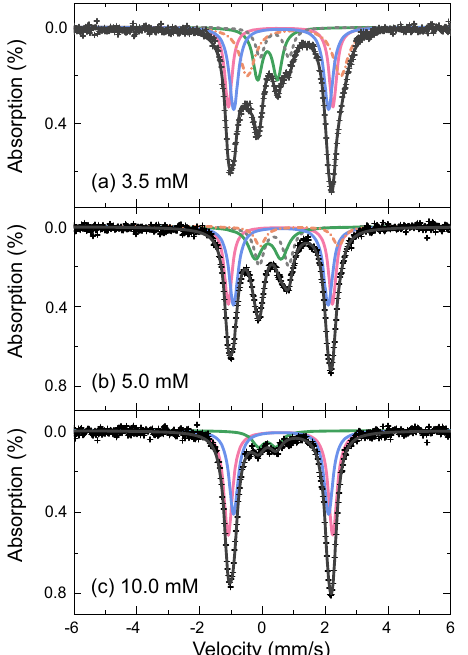
Fig. 5 Mössbauer spectroscopy reveals a variety of FeS cluster species. Room temperature 57 Fe Mössbauer spectra of FeS clusters coordinated with a 3.5 mM, b 5.0 mM and c 10 mM cysteine ligand at pH 9 (FeCl 3 and Na 2 S kept constant at 1 mM). All spectra were folded relative to α Fe, with best fi tting obtained using a least-squares fi tting method, by adding a number of Lorentzian shaped doublets. Crosses represent observed data points with the black line showing best fi t to the collected data. Each FeS cluster species is represented by a coloured line: mononuclear (pink line); [2Fe-2S] 0 (blue line); [2Fe-2S] 2 + (green line); [4Fe-4S] 2 + (grey dashed line); Fe 2 + with 5 or 6 coordination (orange dashed line). Mössbauer fi tting parameters and related species are given in Table 1. Source data are provided as a Source data fi